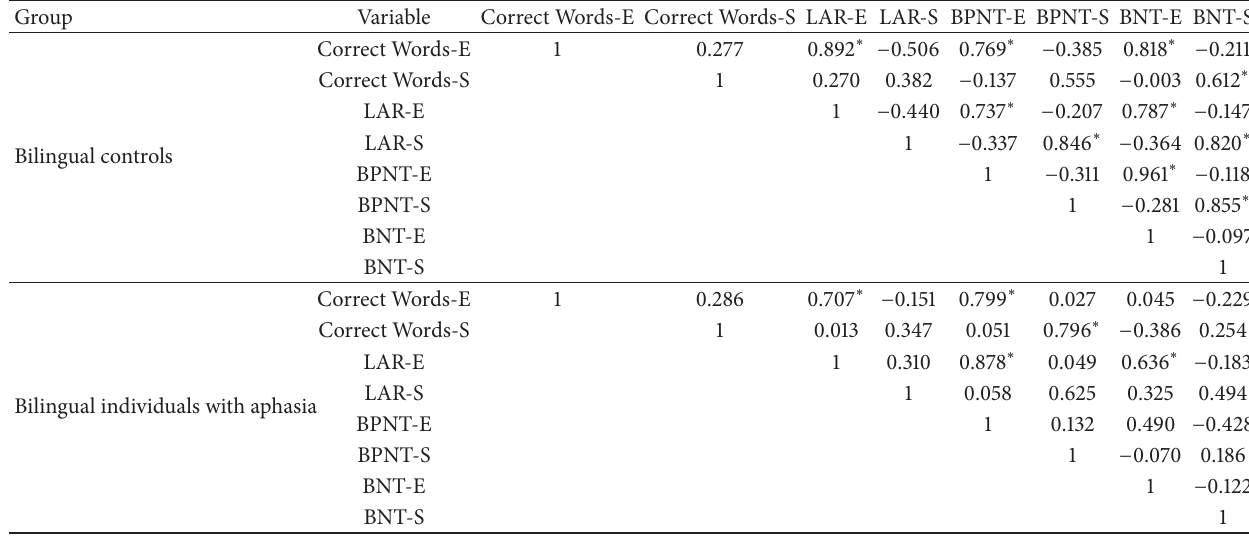
Table 5: Pearson correlations of BNT, BPNT, correct words on the category generation task, and LAR administered for bilingual controls and individuals with aphasia. Correlations significant at 𝑃 < 0.05 are highlighted with an